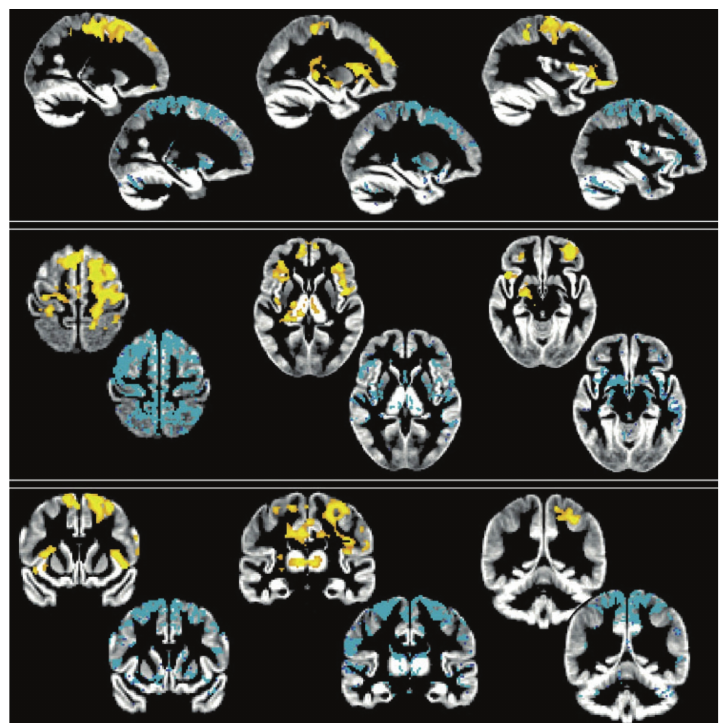
Figure 4: Increase of functional connectivity and lower structural connectivity in a population of ALS patients studied by Douaud et al. [22]. The spatial distribution of the significant increase of functional connectivity in patients (red-yellow scale: P < 0 . 05, corrected) corresponded to the areas where the patients had lower structural connectivity, evaluated by using tract-based spatial statistics and probabilistic tractography, in comparison to healthy controls (in blue, thresholded at 10 streamlines of di ff erence on average) (derived from Douaud et al. [22]). By permission of Oxford University